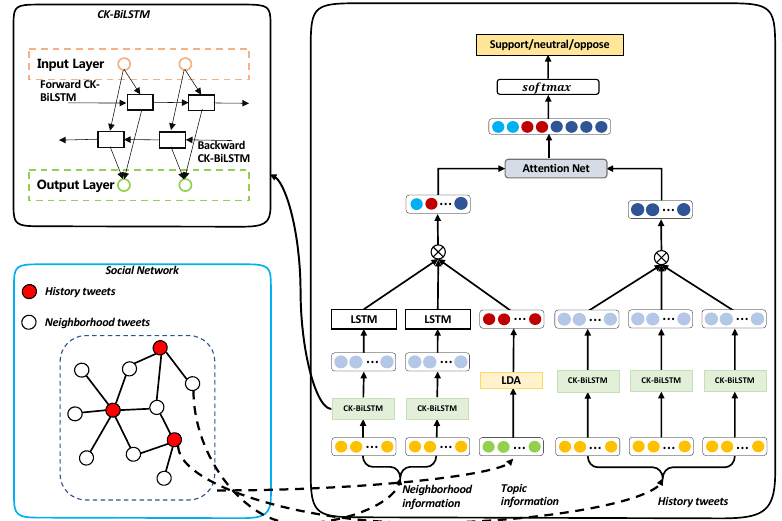
Figure 1. The overall architecture of the proposed ECKEI